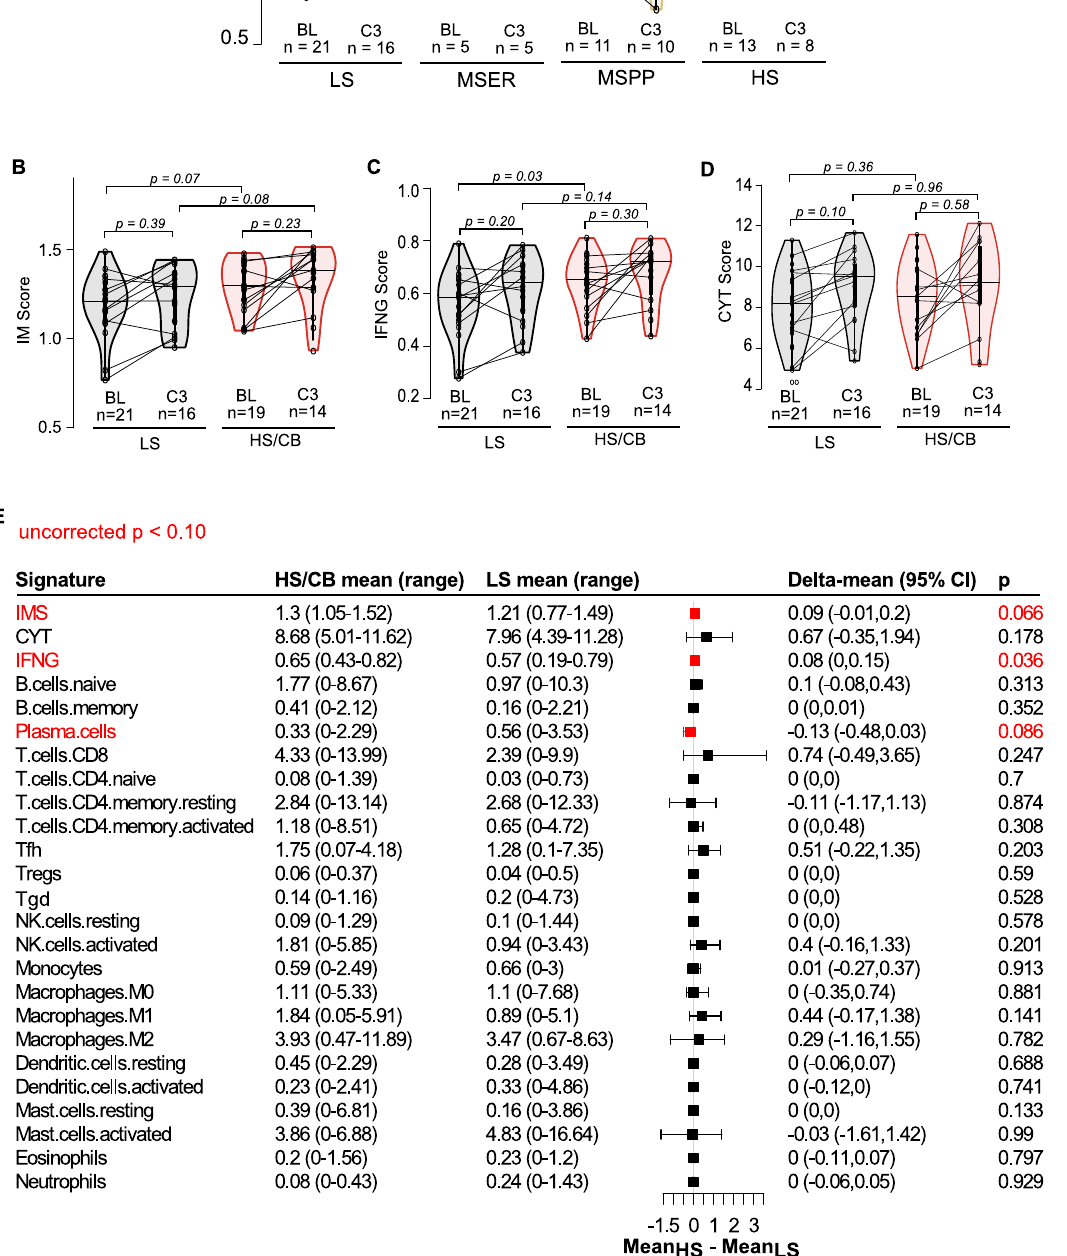
medians of IM, IFNG, and CYT scores in the HS group were highest amongst all sensitivity groups. IFNG ( p = 0.03, two-sided Wilcoxon rank-sum test; Fig. 3C) and IM ( p = 0.07, two-sided Wilcoxon rank-sum test; Fig. 3B, E) scores were higher in HS/CB group compared to LS, while no difference was observed in the CYT score (Fig. 3D, E). Patients with IFNG scores greater than the cohort median (IFNG = 0.61) had improved OS (HR =